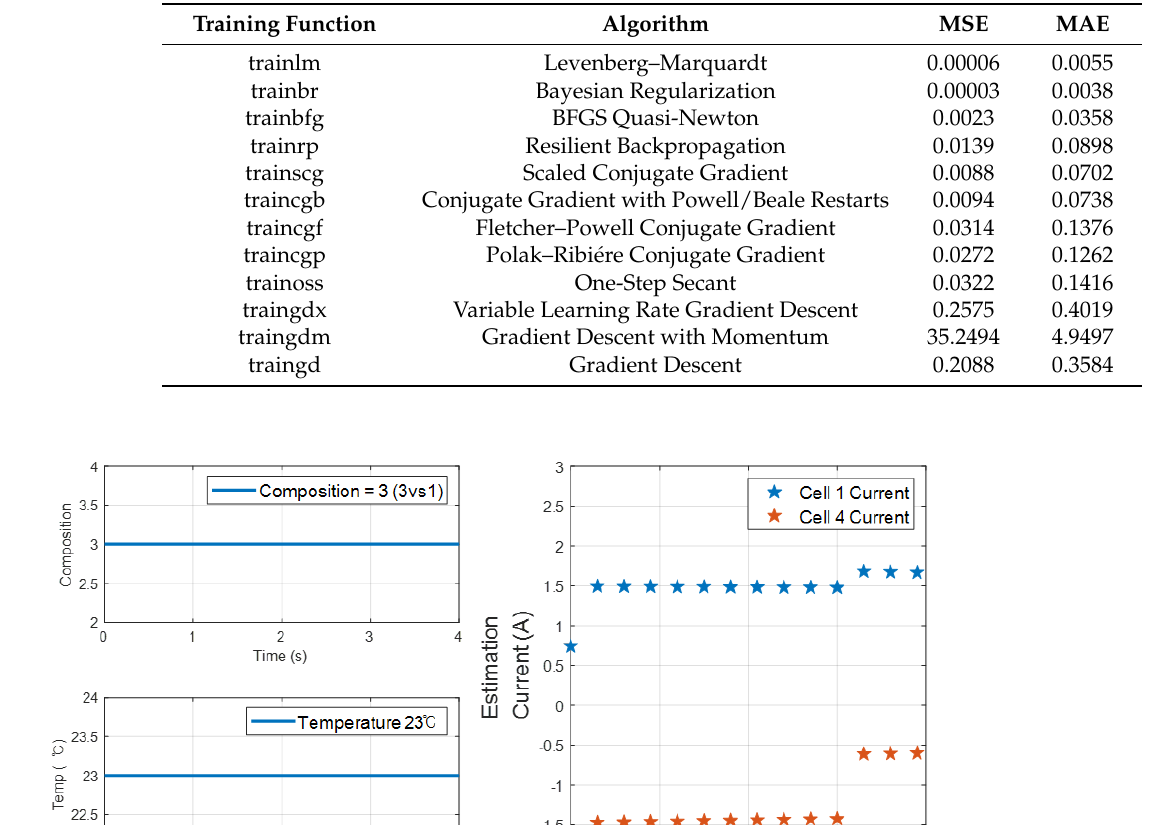
Table 7. Results of performance analysis of model according to training function.